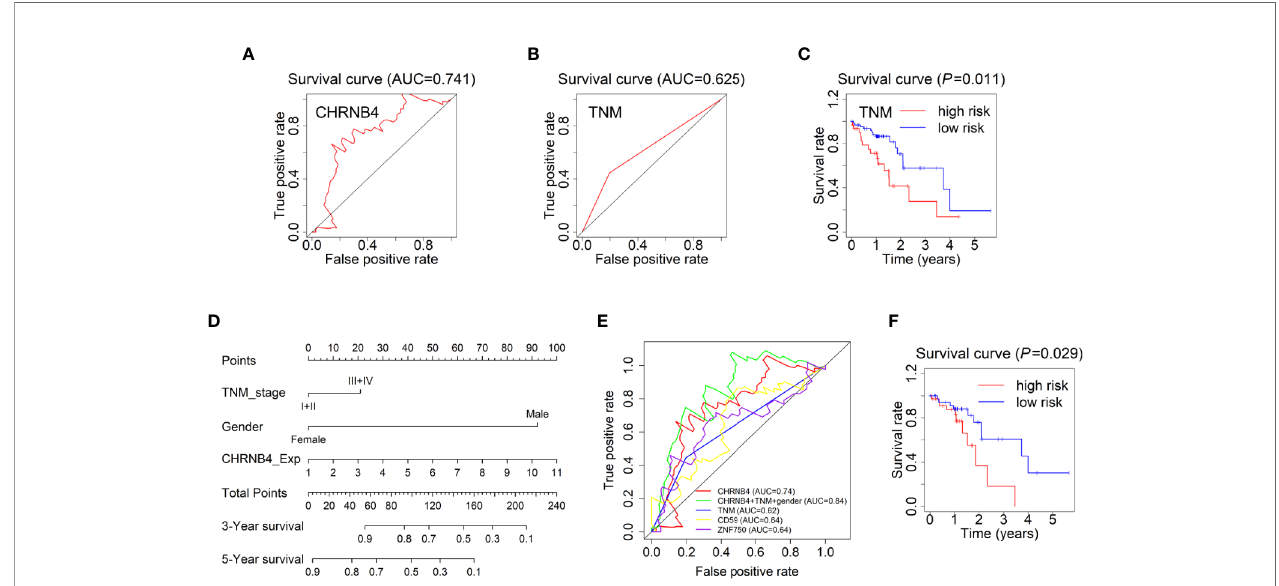
FIGURE 3 | Forecast models and survival nomogram to predict the survival of ESCC patients. (A) The 3 year-ROC Forecast models of CHRNB4 in ESCC. (B, C) ROC and survival curves of the models according to TNM staging in ESCC-TCGA. (D) ESCC survival nomogram combined the TNM stage, gender, and the expression of CHRNB4. (E) The prognosis ability of our CHRNB4, prognostic nomogram, TNM, and two published biomarkers (CD59 and ZNF750). (F) Survival curves of the